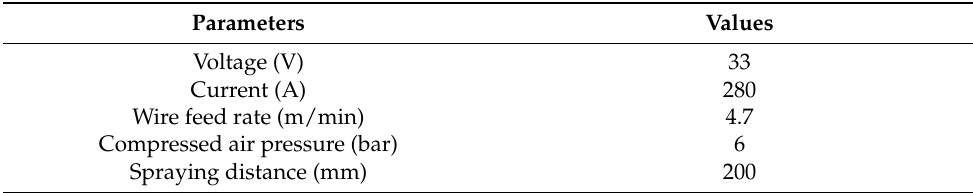
Table 1. Arc spraying parameters.